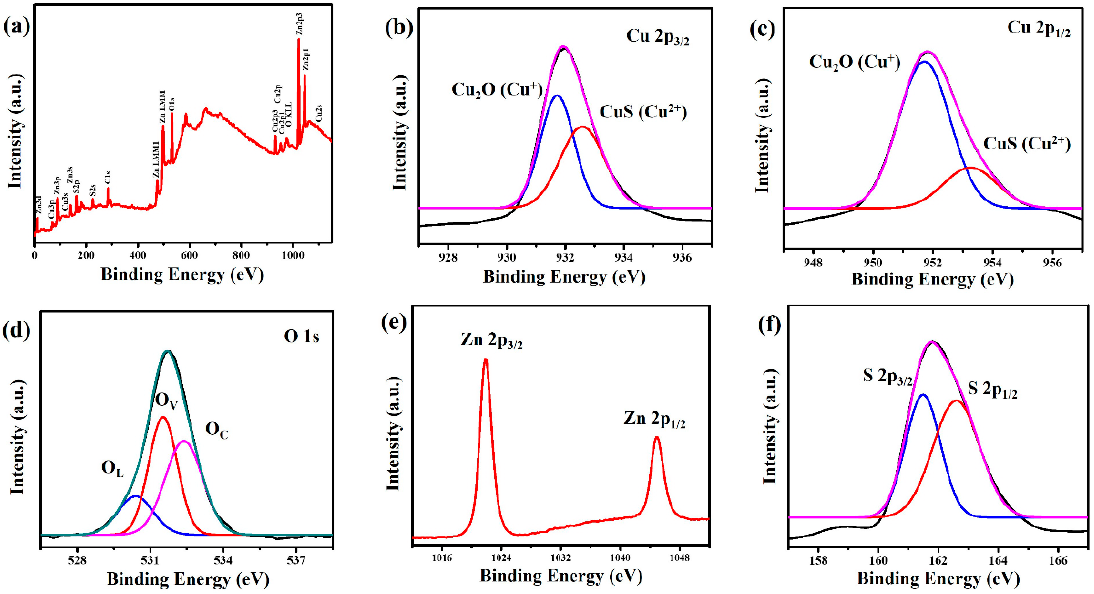
Figure 4. The XPS spectra of the Cu 2 O/CuS/ZnS nanocomposite: ( a ) survey spectrum, ( b ) Cu 2p 3/2 , ( c ) Cu 2p 1/2 , ( d ) O 1s, ( e ) Zn 2p, and ( f ) S 2p. ( c ) Cu 2p 1/2 , ( d ) O 1s, ( e ) Zn 2p, and ( f ) S